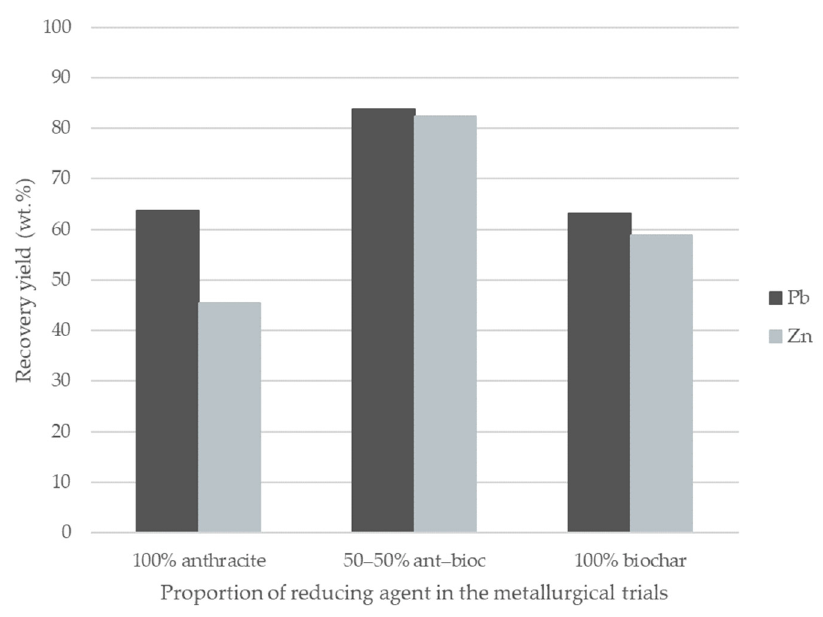
Figure 5. Recovery yields per element in the filter dust